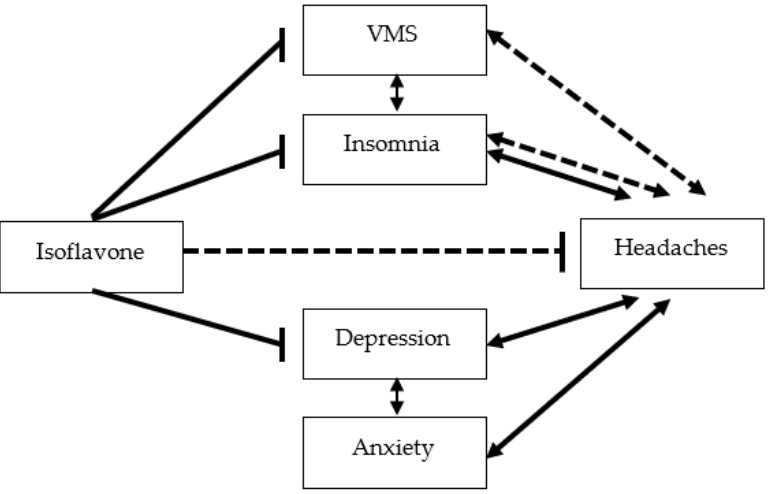
Figure 2. Possible pathways from isoflavone to headache. Arrows, bidirectional relationships; T-bars, inhibitory relationships; solid lines, relationships suggested from previous studies; dashed lines, relationships suggested in this study.